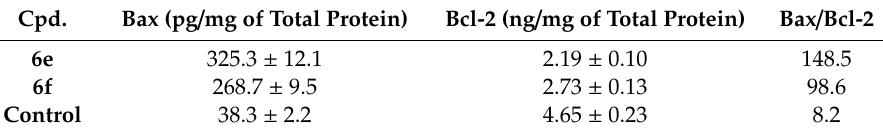
Table 3. Effect of conjugates 6e and 6f on the expression levels of Bcl-2 and Bax in MCF-7 cancer cells. Cpd.